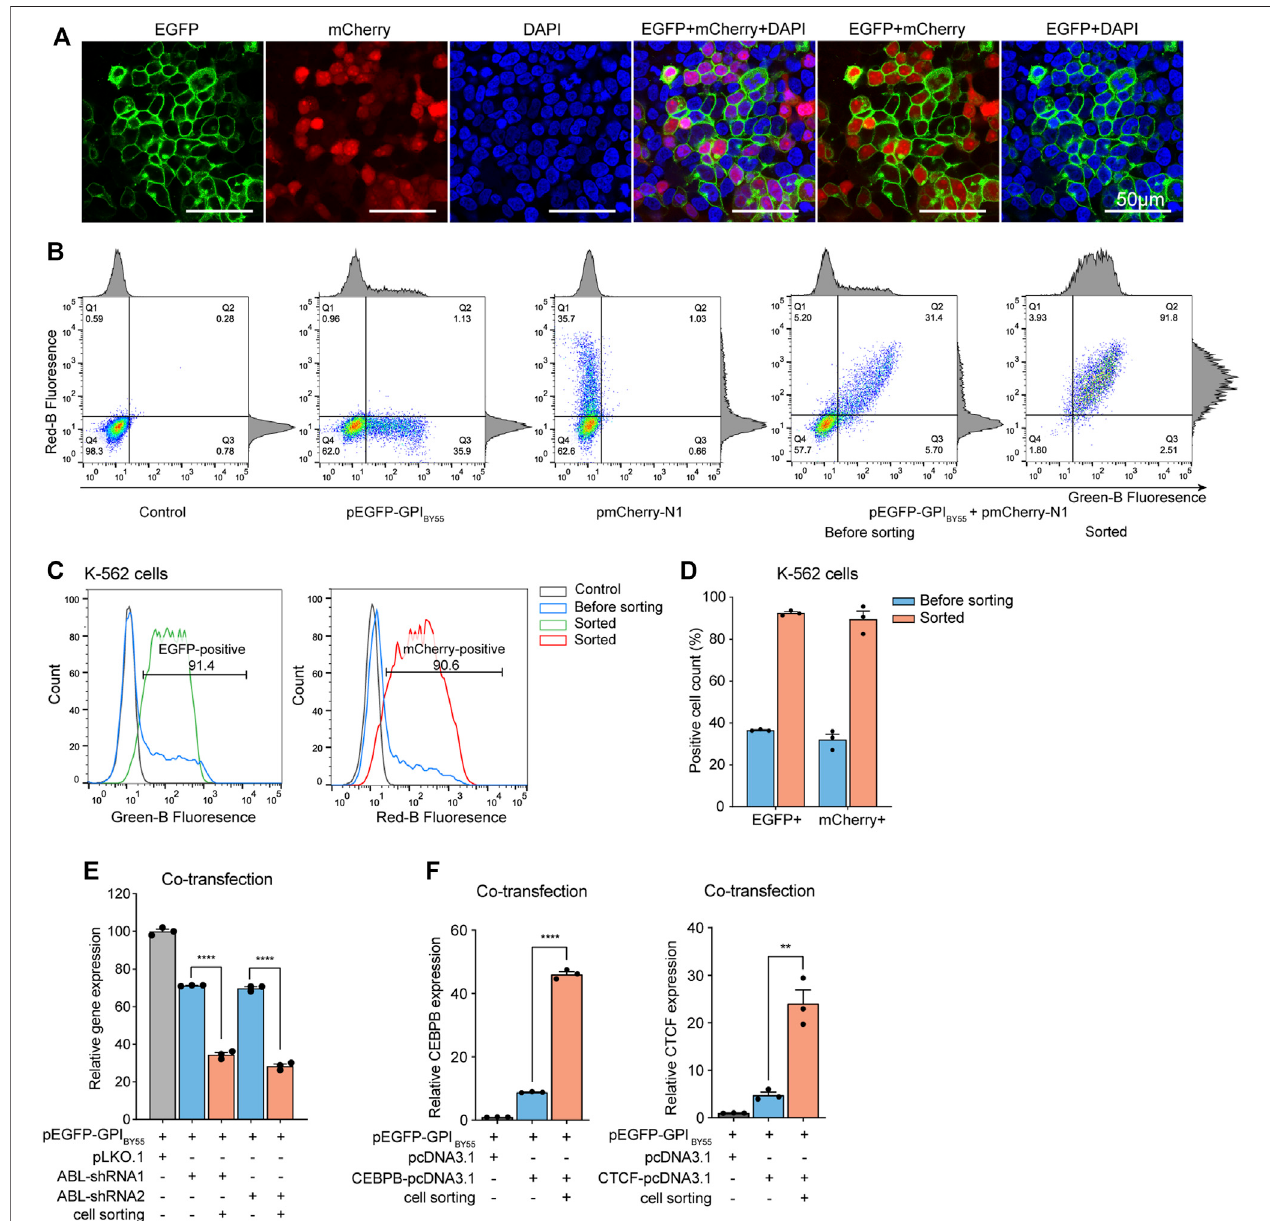
FIGURE 7 | The sorting plasmid co-transfection strategy. (A) Laser scanning confocal microscopy of Lenti-X 293T cells co-transfected with the pEGFP-GPI BY55 andpmCherry-N1plasmids.DAPIstainscellnuclei.Cellswereobservedat×200magni fi cation,scalebar=50 μ m. (B) FlowcytometrydensitydotplotoftheK-562cells co-transfected with the pEGFP-GPI BY55 and pmCherry-N1 plasmids with or without enrichment by cell sorting. Cells transfected with pEGFP-GPI BY55 or pmCherry-N1 were used as fl uorescence compensation controls. The percentage of cells in each quadrant is represented. Q1: EGFP − /mCherry + ; Q2: EGFP + /mCherry + ; Q3: EGFP + /mCherry − ; Q4: EGFP − /mCherry − . The corresponding fl ow cytometry histograms on the border represent cell counts vs. fl uorescence intensity for green or red channels. (C) Flow cytometry histograms showing the normalized cell counts vs. fl uorescence intensity for the green and red channels. The gray line represents the untransfected negative control K-562 cells, the blue line represents the K-562 cells co-transfected with pEGFP-GPI BY55 and pmCherry-N1, and the green/red lines representtheco-transfectedcellsenrichedbycellsorting. (D) Thebarchartshowingthepercentageof fl uorescencepositivecellsforEGFPandmCherry,respectively,in the co-transfected K-562 cells with or without enrichment by cell sorting. Values are from three biological replicates. (E) The relative ABL gene expression level in K-562 cellsco-transfectedwithpEGFP-GPI BY55 sortingplasmidandABL-shRNA1 orABL-shRNA2, withorwithoutenrichmentbycellsorting.ValuesarefromthreeRT-qPCR experiments with β -actin as the reference gene. (F) The relative gene expression level of CEBPB and CTCF genes in K-562 cells co-transfected with pEGFP-GPI BY55 sortingplasmid and CEBPB or CTCF overexpressionplasmid,respectively,withor without enrichmentbycell sorting. Values arefrom three RT-qPCRexperiments with β -actin as the reference gene. Error bars, means ± SEM. Two-tailed t -test, ** p < 0.01 **** p < 0.0001.